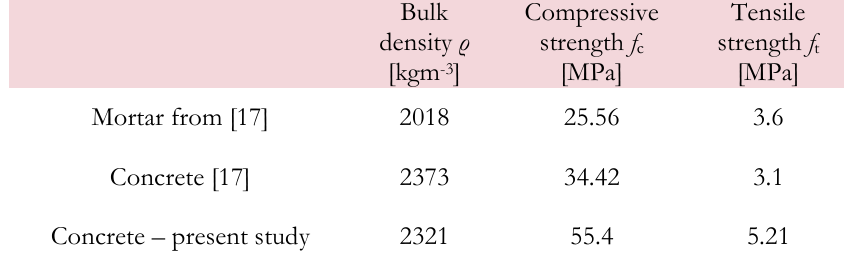
Table 5: Comparison of selected mechanical characteristics of used concrete with data adapted from literature [17] Fracture mechanical properties